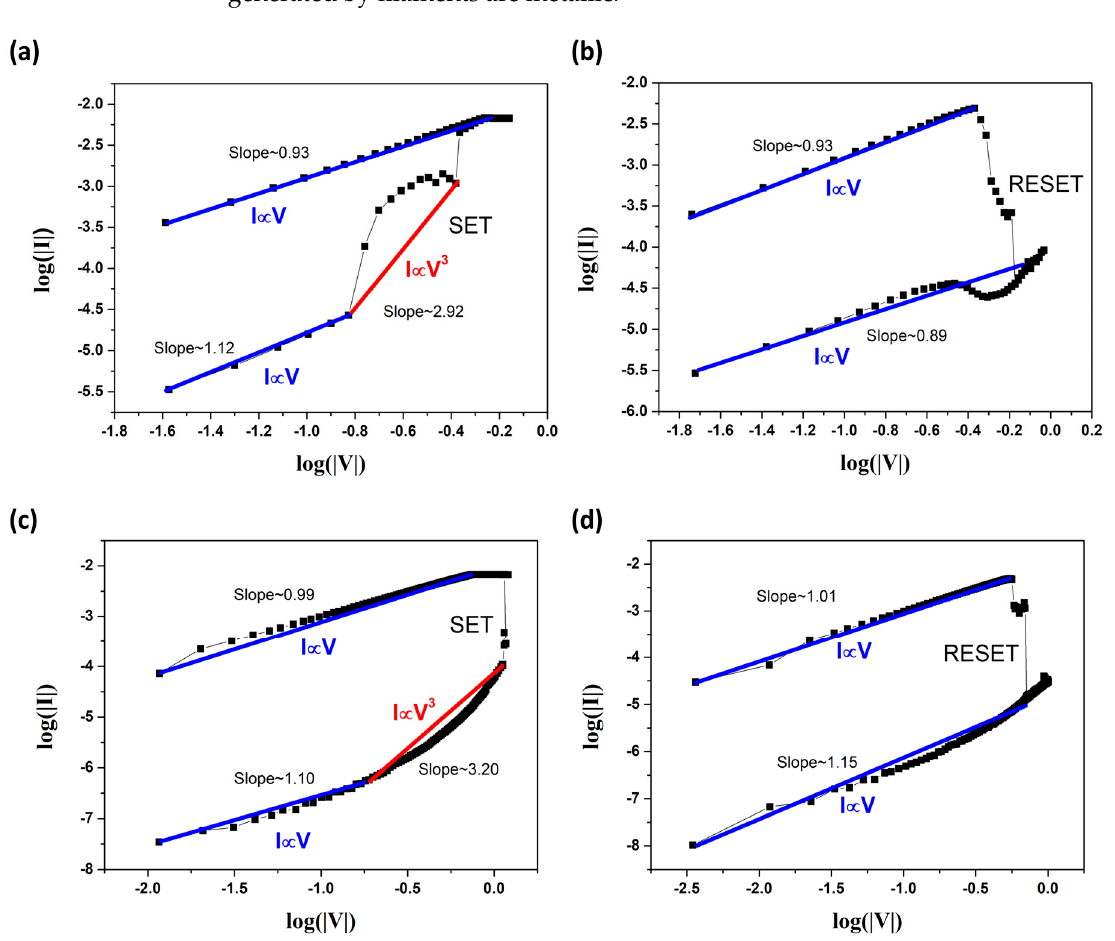
Figure 4. ( a ) Log(I)–Log(V) plots of the device with Ag TE under positive voltage sweeps and ( b ) under negative voltage sweeps. ( c ) Log(I)–Log(V) plots of the device with Cu TE under positive voltage sweeps and ( d ) under negative voltage sweeps.